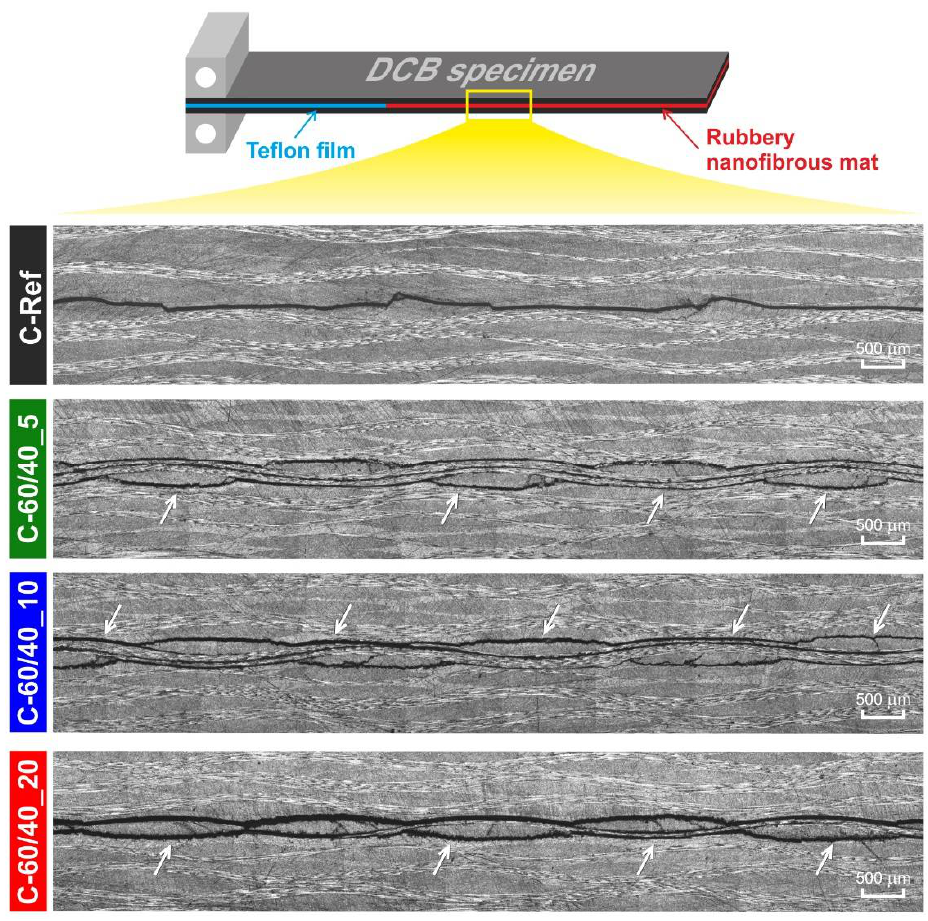
Figure 14. Micrographs of DCB specimens after the delamination tests. The arrows indicate the central plane where the Teflon film trigger is inserted.